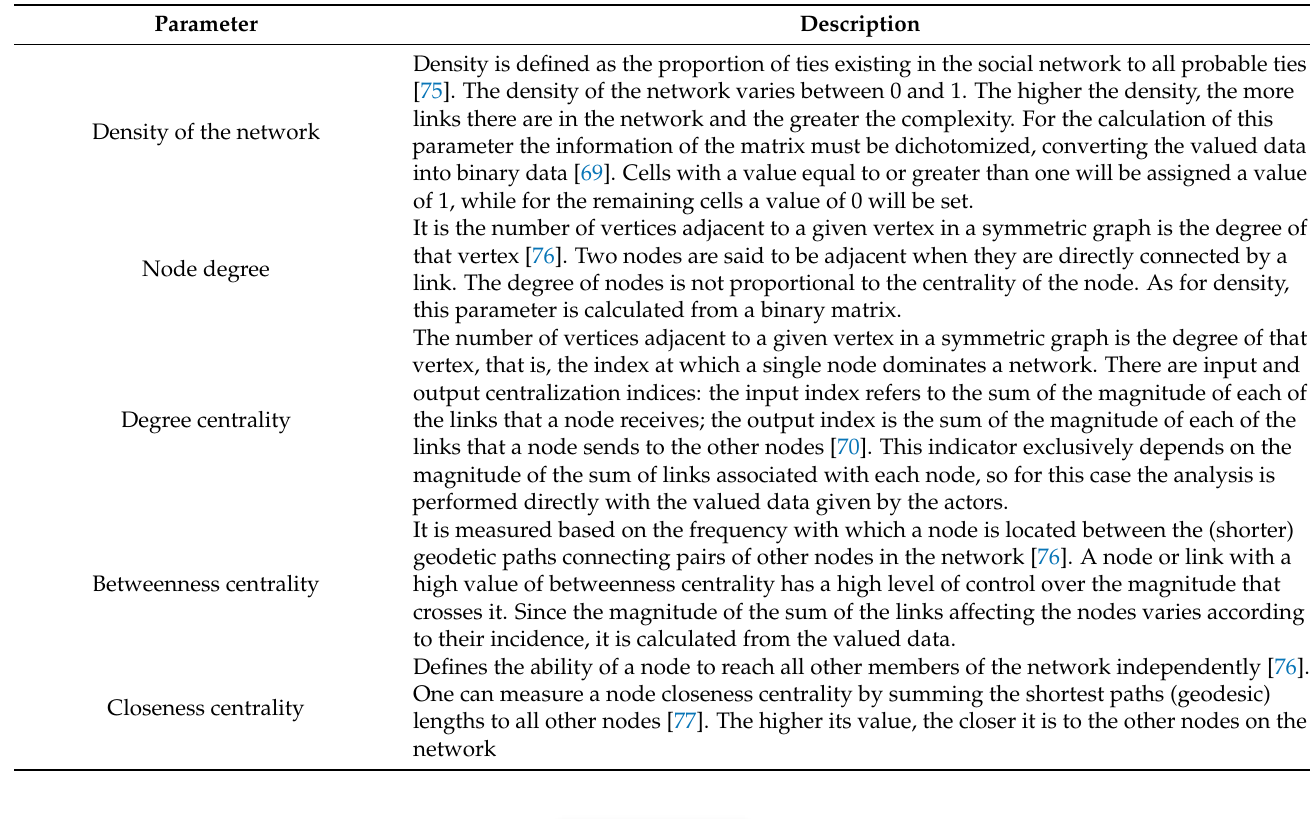
Table 2. Description of parameters used for the analysis of results.